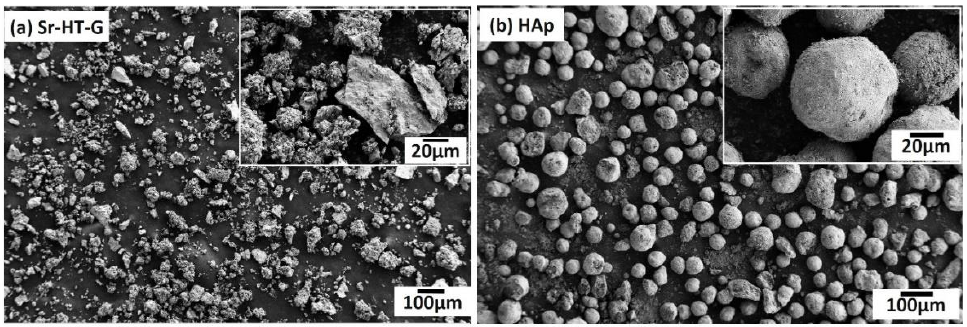
Figure 1. Feedstock morphology of strontium–hardystonite–gahnite (Sr–HT–G) ( a ) and hydroxyapatite (HAp) ( b ).